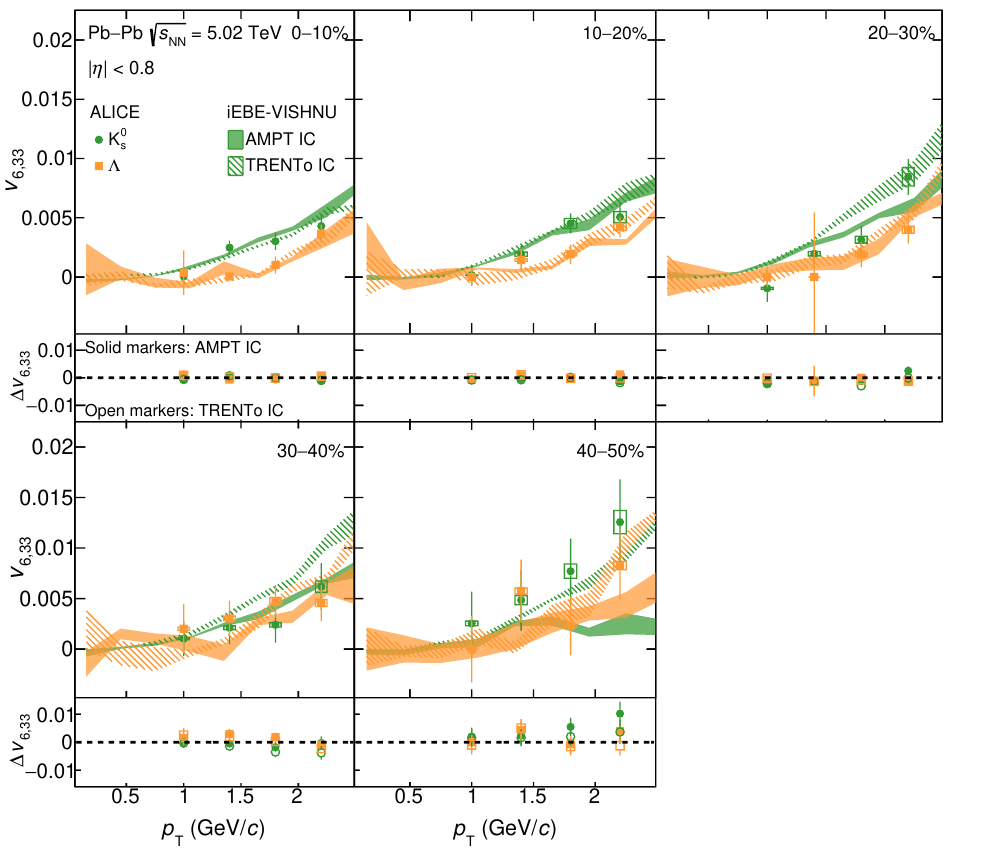
Figure 21 . The p T -di(cid:11)erential v 6 ; 33 of K 0 and (cid:3) + (cid:3) in the 0{10% up to 40{50% centrality S p intervals of Pb-Pb collisions at s NN = 5 : 02 TeVcompared with iEBE-VISHNU hybrid models with two di(cid:11)erent sets of initial parameters: AMPT initial conditions ( (cid:17)=s = 0.08 and (cid:16)=s = 0) shown as solid bands and TRENTo initial conditions ( (cid:17)=s (T) and (cid:16)=s (T)) as hatched bands. The bottom panels show the di(cid:11)erence between the measurements and each model. Statistical and systematic uncertainties are shown as bars and boxes,